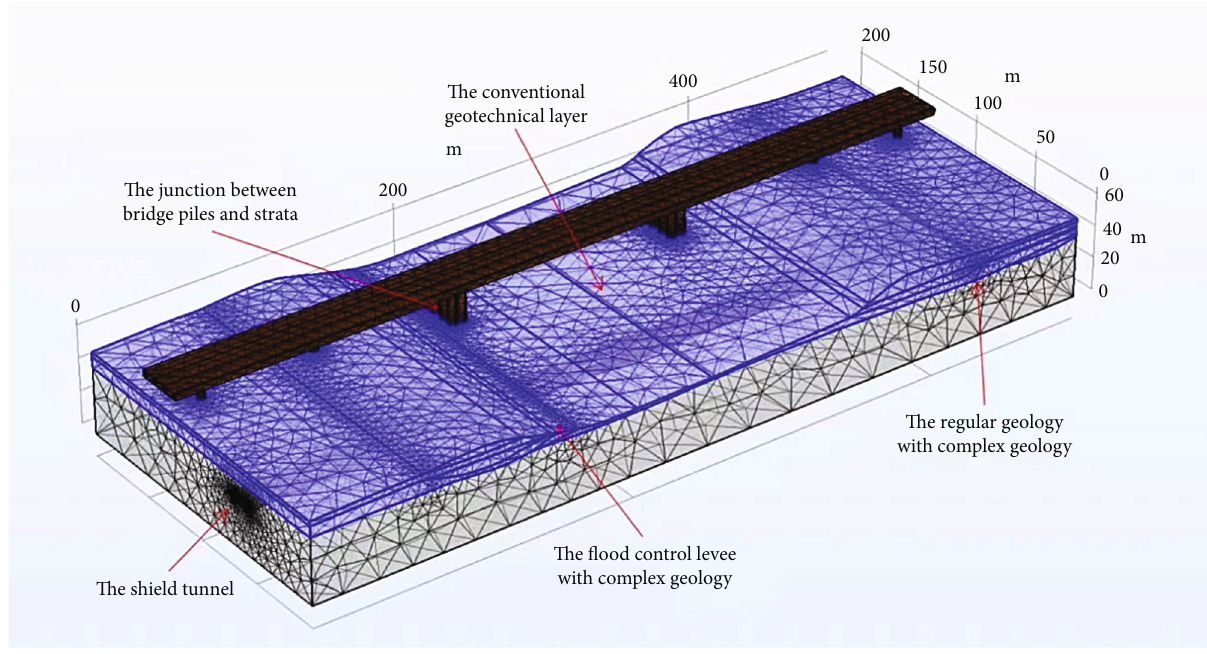
Figure 5: Geometric model meshing diagram.